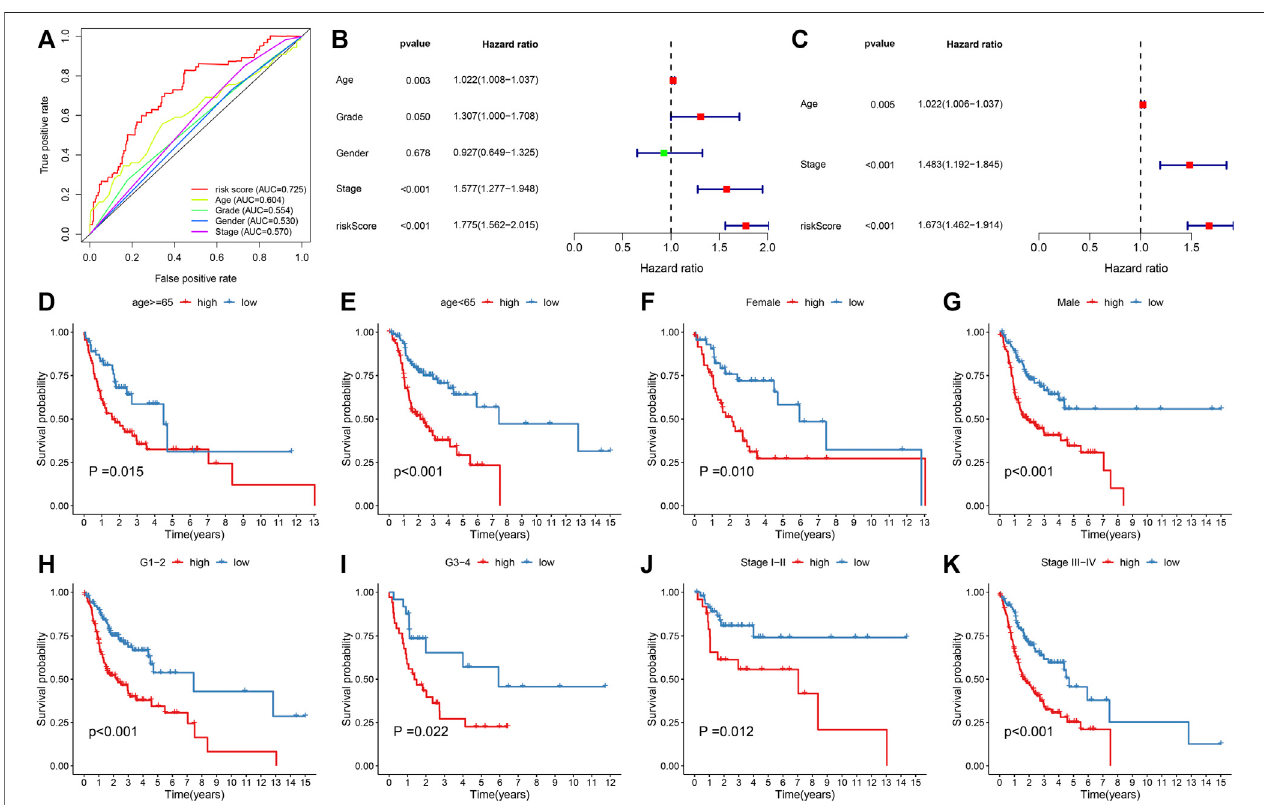
FIGURE3| AssessmentofthereliabilityandindependencyofIRSinOSCCprognosisintheTCGAcohort. (A) Comparisonofthepredictiveef fi cacyoftheIRSwith clinicopathological factors via ROC curves. (B,C) Uni- and multivariate cox regression models for the associations of IRS and clinicopathological factors with OSCC prognosis. (D – K) The K – M curves of OS between high- and low-risk patients in each subgroup, including age ≥ 65 and < 65; female and male; G1-2 and G3-4; stage I-II and stage III-IV.